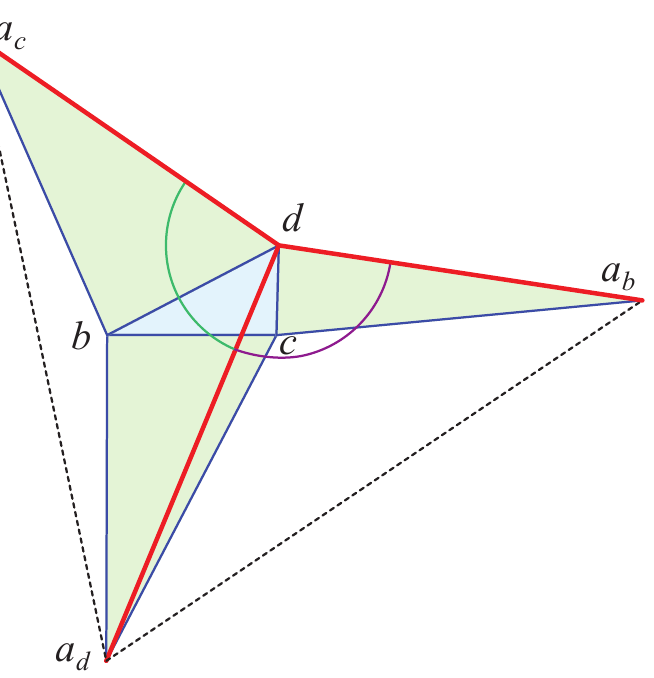
Figure 12. (cid:52) a b da d and (cid:52) a c da d : triangle angles at d are < π